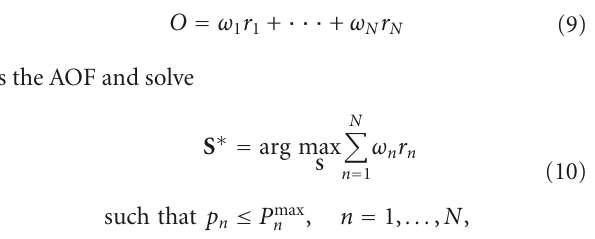
SB (ISB) [3] and Successive Convex Approximation for